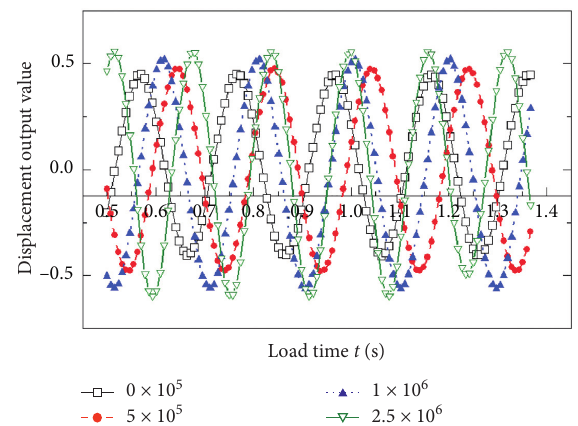
Figure 17: Dynamic strain of test plate under fatigue